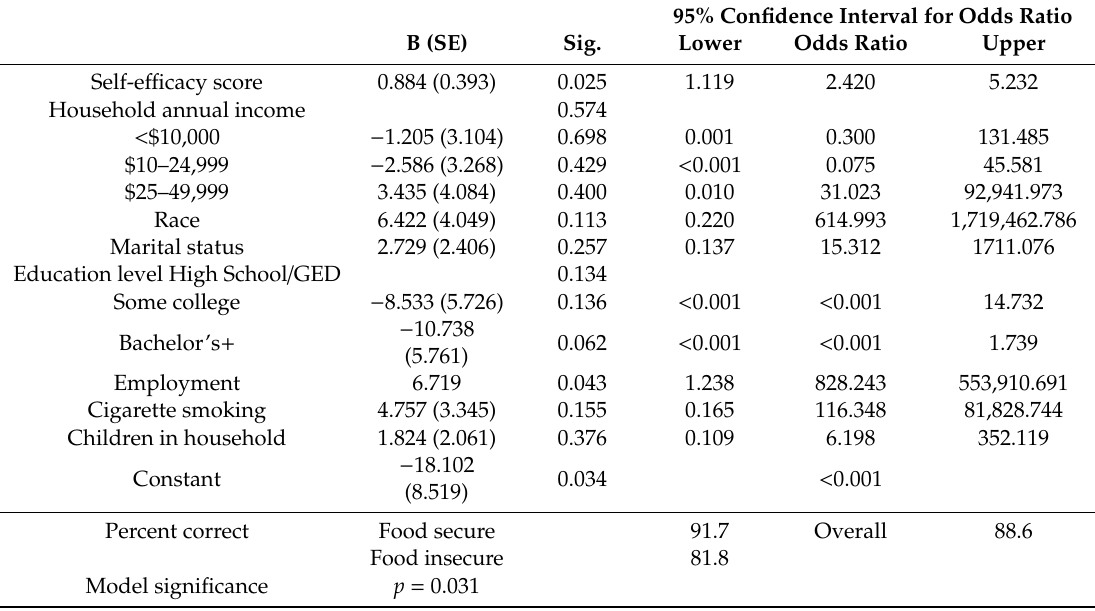
Table A1. Logistic regression model of predictors of food security status among low-income Iowa women ( n =